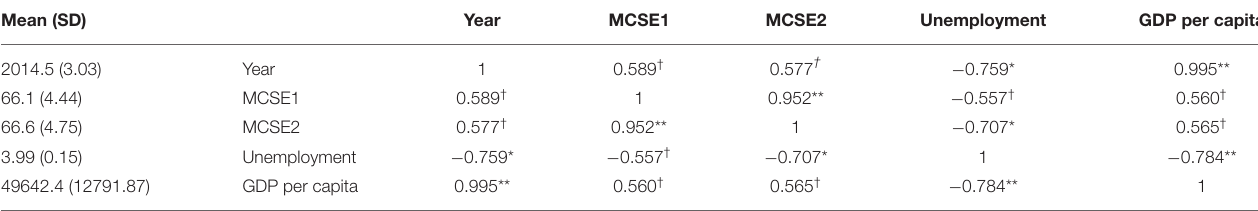
TABLE 2 | Means, standard deviations, and correlations between variable.